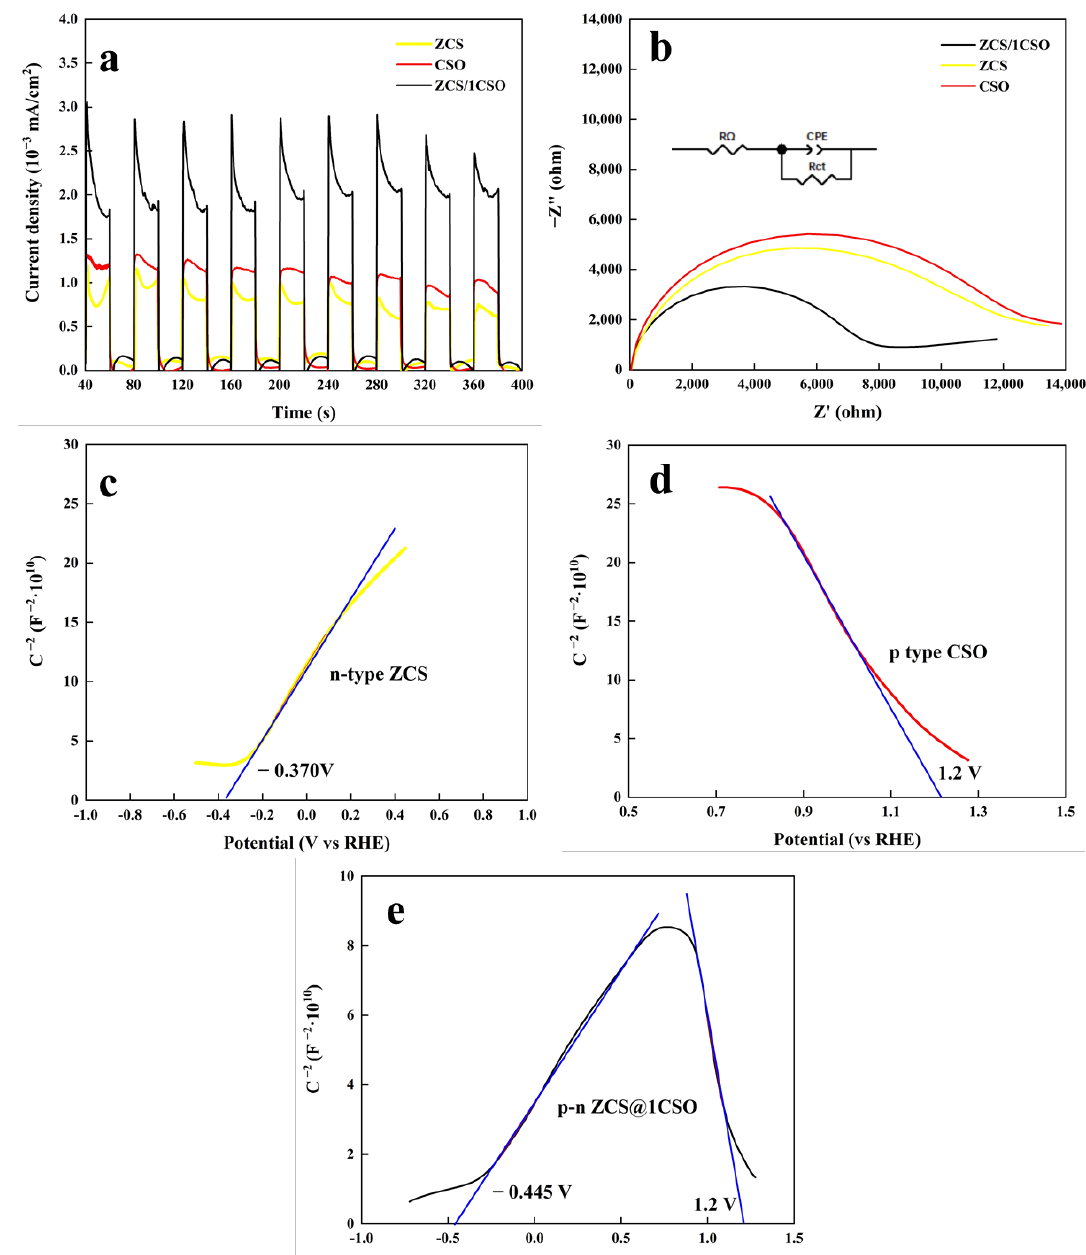
Figure 11. The transient photocurrent responses ( a ), Electro-chemical impedance spectra ( b ) and Mott – Schottky curves ( c – e ) of ZCS, CSO, and ZCS/1CSO.